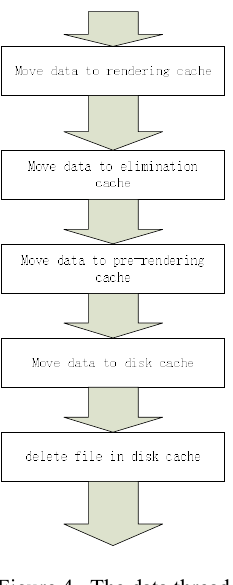
Figure 4. The data thread